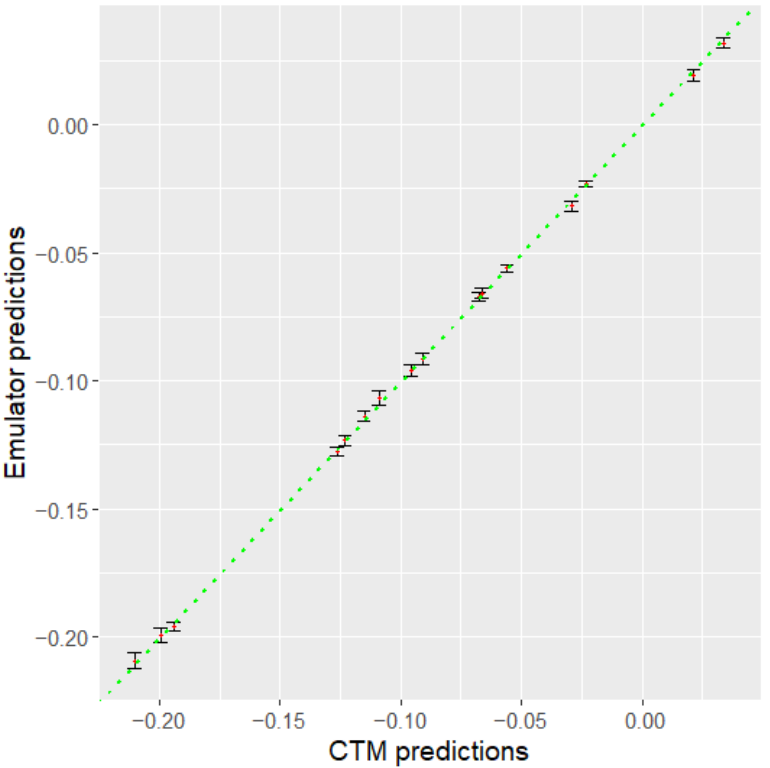
Figure 4. Emulator predictions of ∆ PM 2.5 ( µ g/m 3 ) in Greater Perth versus the CTM. The CCAM-CTM output ( x -axis) is plotted against the corresponding emulator predictions ( y -axis) for the validation dataset, with 95% confidence bounds on the emulator predictions. The green line is a line of